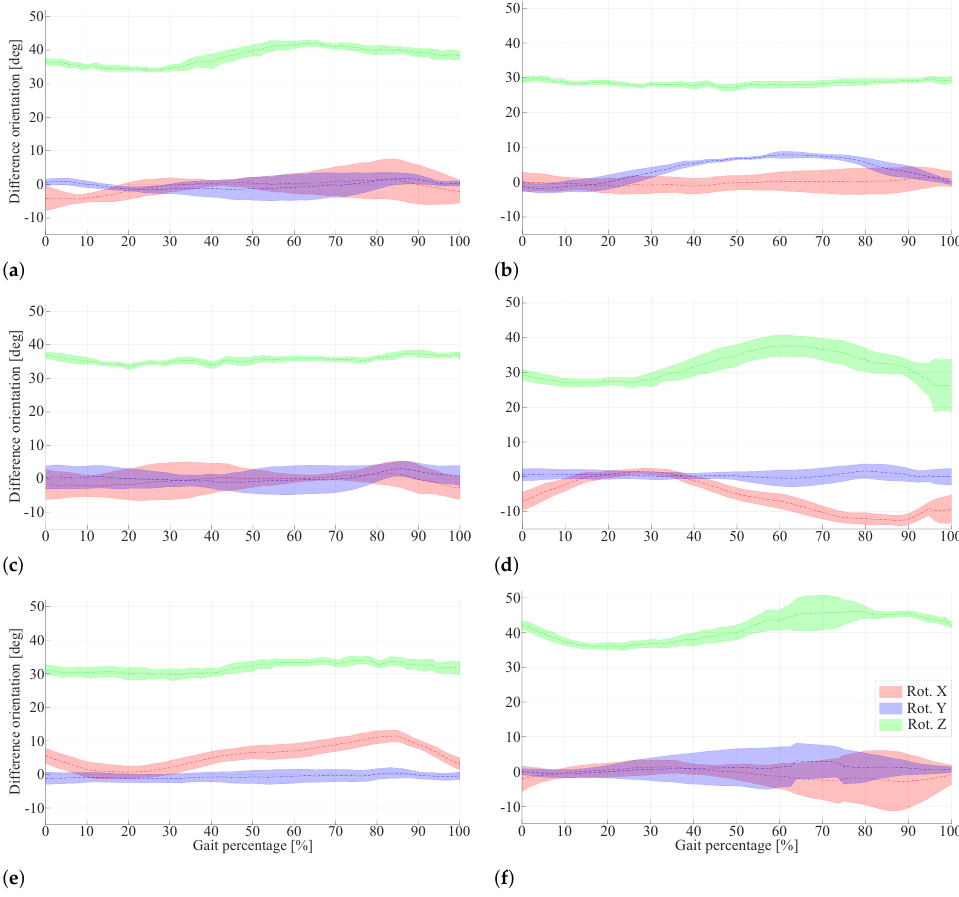
Figure 7. The difference of orientation’s outcomes per subject. ( a ) Subject 1, ( b ) Subject 2, ( c ) Subject 3, ( d ) Subject 4, ( e ) Subject 5, ( f ) Subject 6. The red curve refers to the Rot X , the blue curve refers to the Rot Y , and the green curve refers to the Rot Z . In all cases, the dotted signal represents the average of the cycles for each orientation signal per subject; and the shaded curve represents the standard deviation of the cycles for each orientation signal per